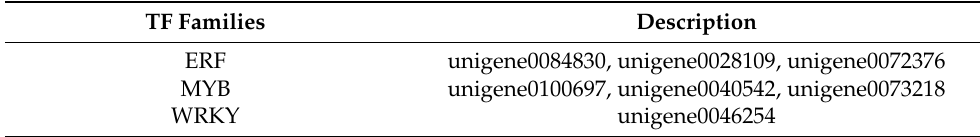
Table 4. Screening of differential transcriptional factor genes.